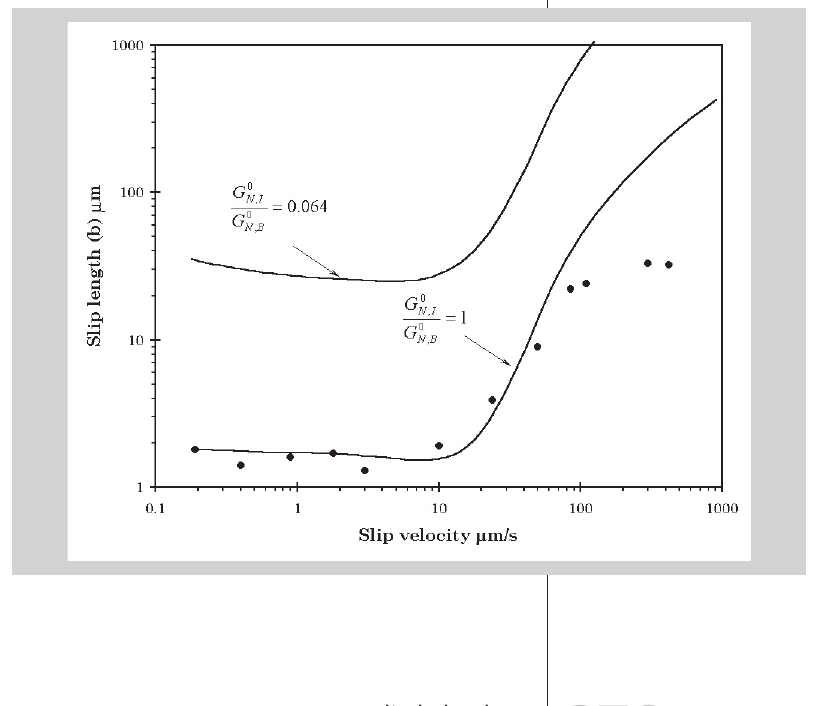
Figure 2: Comparison of experimental data of slip length vs. slip velocity with model prediction. The experimental data is by Durliat et al.[13] and is for PDMS melt. The upper curve is corresponds to the lower value of interfacial modulus than that of the bulk modulus. For both interfacial and bulk modulus equal to each other the model predicts the experimental data